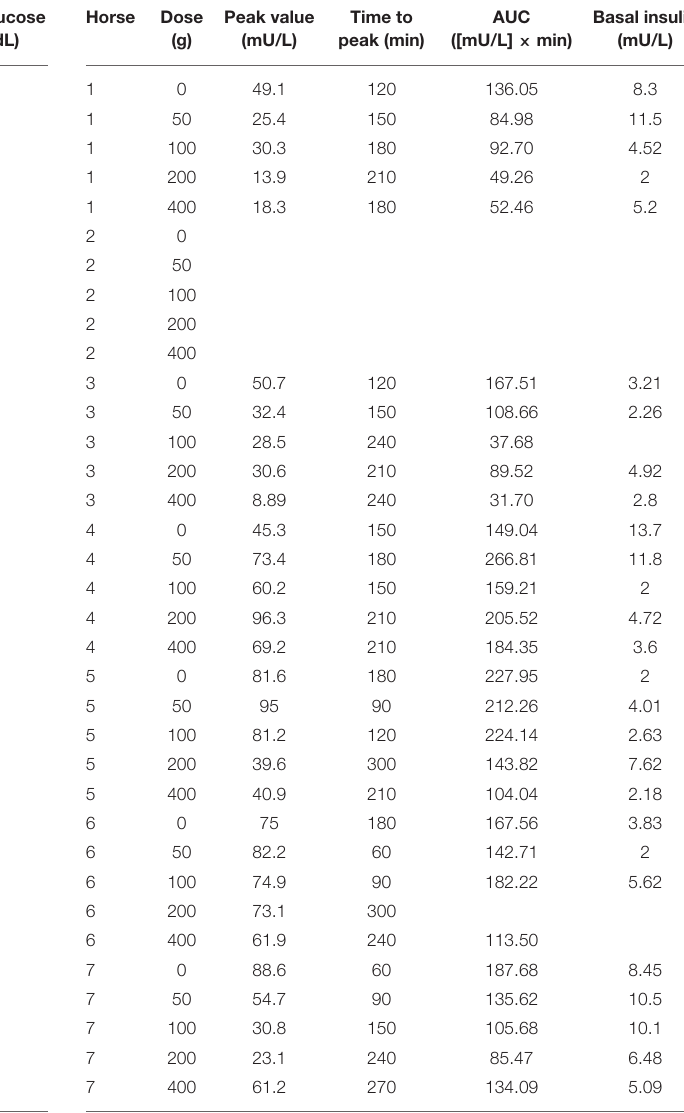
TABLE 3 | Glucose values per horse and aleurone dose. Horse Dose Peak value (g) (mg/dL)